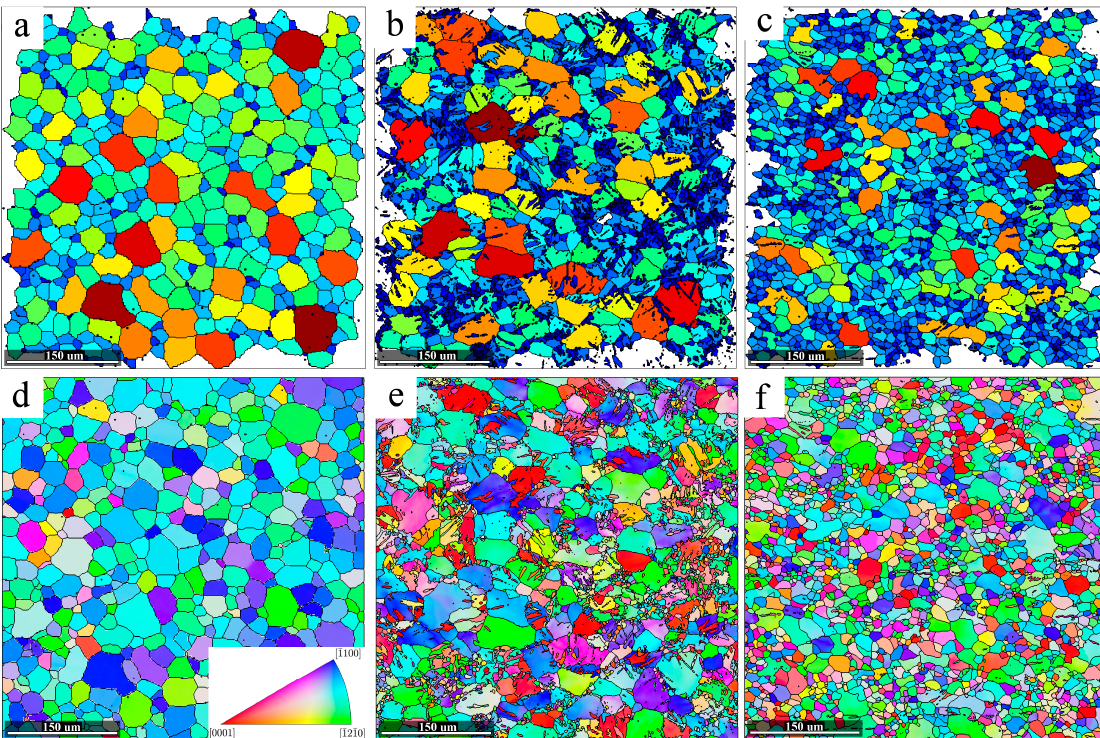
Figure 2. ( a – c ) grain-structure maps and ( d – f ) inverse pole figures along the extrusion direction (ED), from ( a , d ) the initial state; ( b , e ) the as-quenched specimens; and ( c , f ) the air-cooled specimens. In ( d ), an inset color-coded key triangle indicates crystallographic orientations.